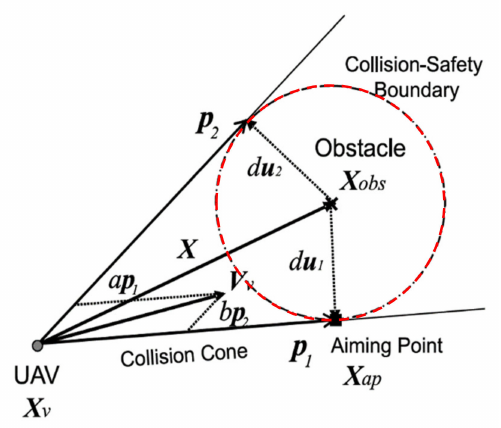
Figure 11. Collision cone and aiming point